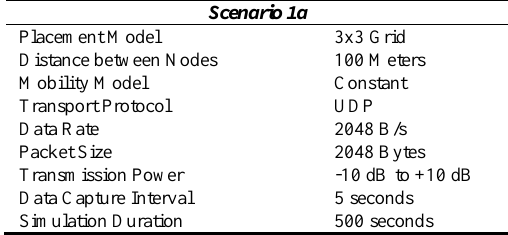
Figure 7. Packets Sent vs Packets Received at Transmission Power